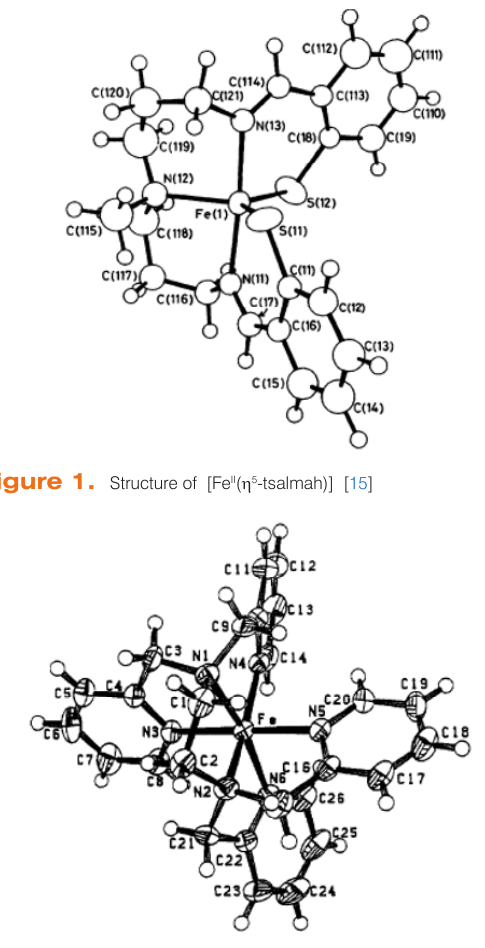
Figure 2. Structure of [Fe II ( η 6 -tpen)] 2+